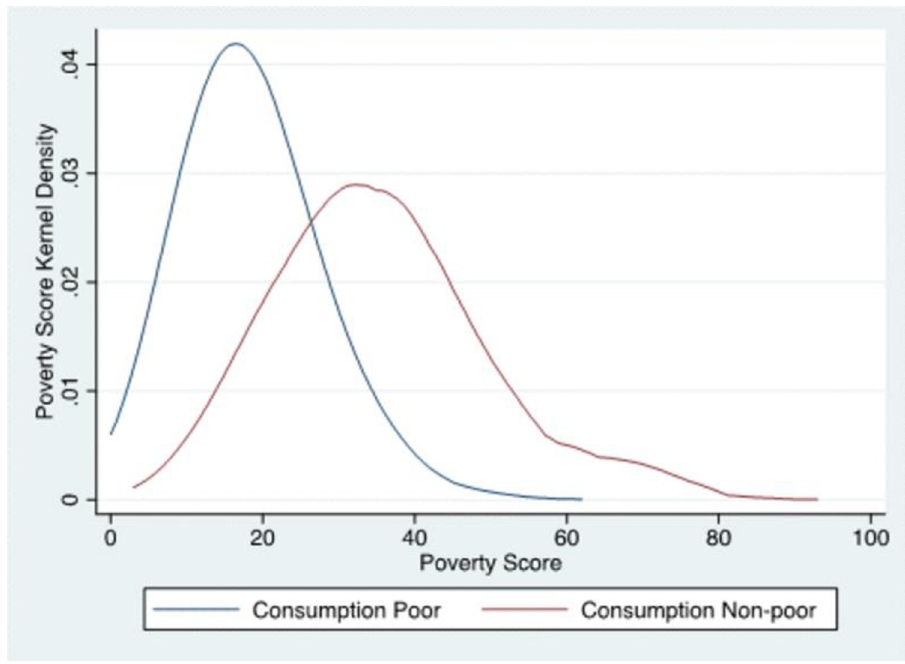
Fig 1. The Simple Poverty Score and consumption poverty. Source: Authors’ estimations using HIES 2015–16. https://doi.org/10.1371/journal.pone.0283938.g001 indicators are categorized as poor. Table 2 presents the poverty headcounts based on MPI and SPS for each district for which SPS data is available. As the table shows, the level of poverty, or the headcount, is generally much lower with the SPS than it is with the MPI. Nevertheless, a correlation coefficient of 0.74 indicates a strong linear relationship between the two measures of poverty.